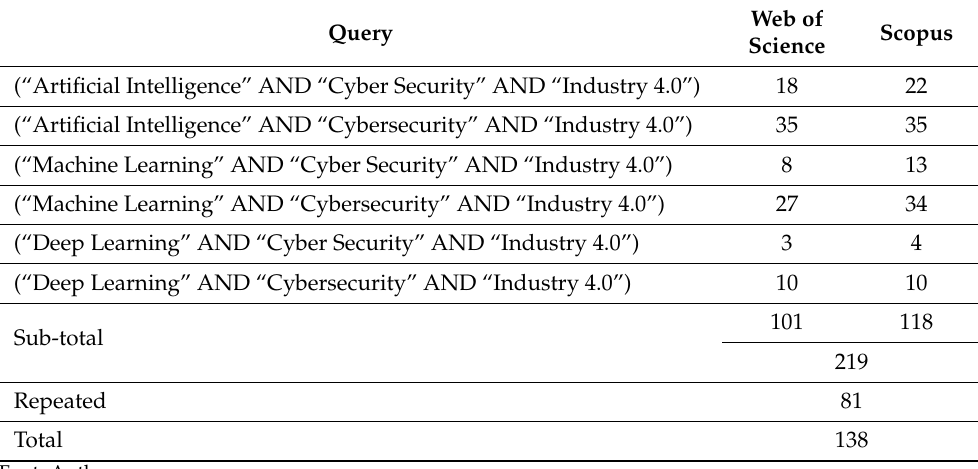
Table 1. Search results by